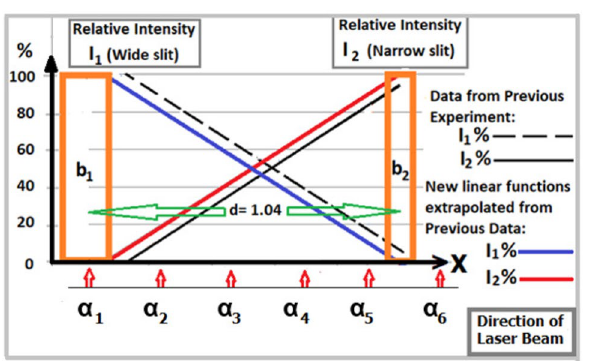
Figure 7. Based on Relative intensities extrapolated from 23 (the same slit-widths b 1 , b 2 ) one can determine the relative intensity I 1 / I 2 in each laser beam